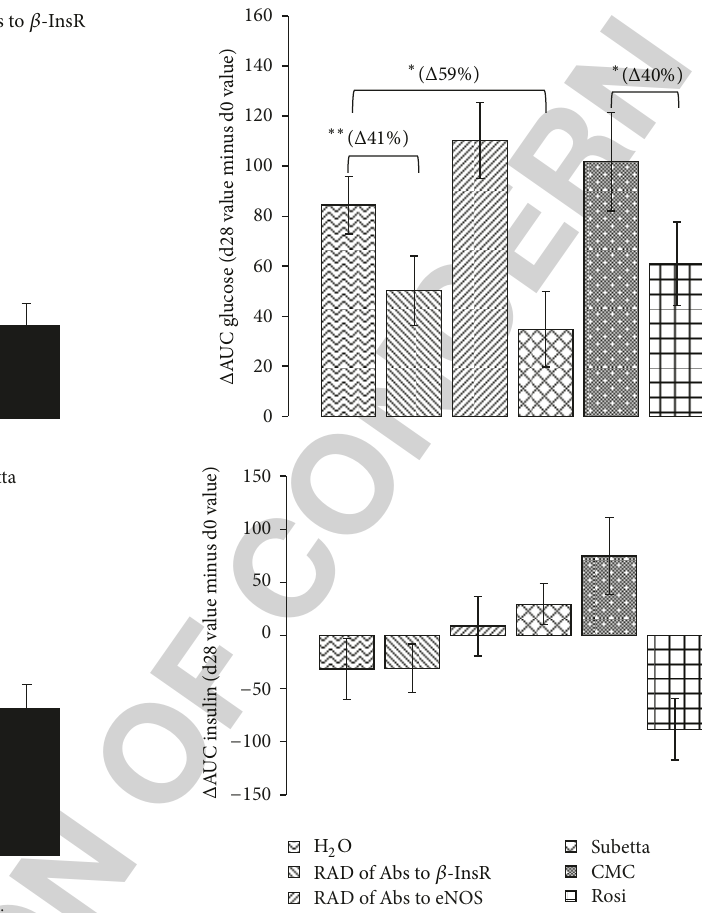
Figure 3: Time-related variations of AUC glucose and AUC insulin values in each group between d0 and d28. Such a calculation (d28 value minus d0 value) enables intergroup comparison. ∗∗ 𝑃 < 0.01 versus d0-H 2 O-treated GK/Par group. ∗ 𝑃 < 0.05 versus d0-CMC- treated GK/Par